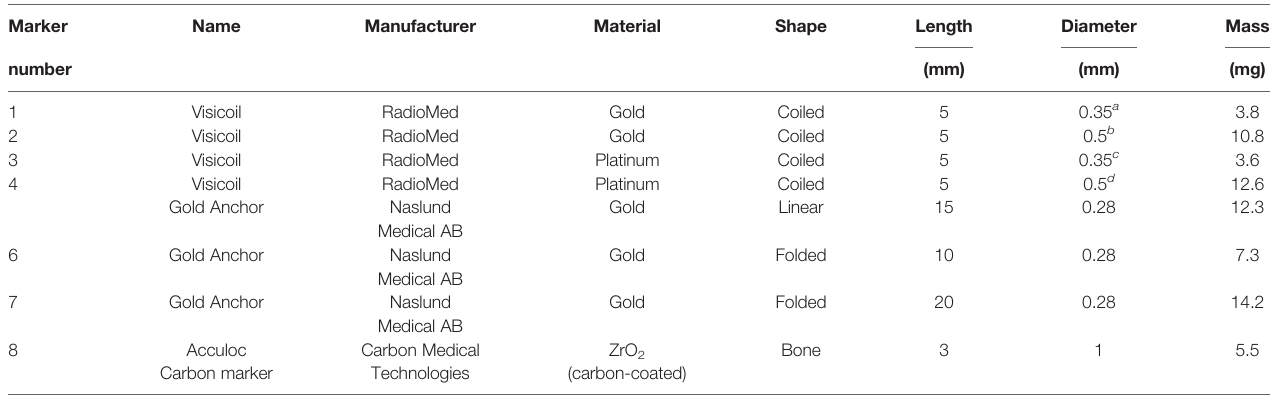
TABLE 1 | Properties of all fi ducial markers used in this study for the imaging and proton beam experiments.